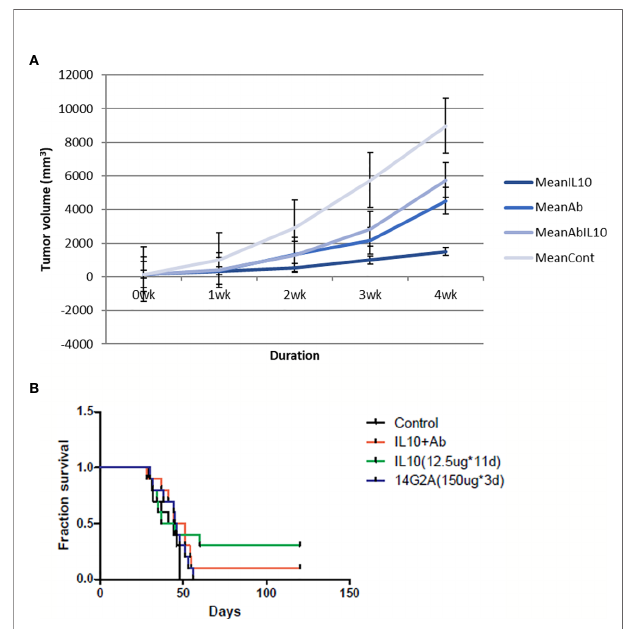
FIGURE 3 | 4T1 tumor volume and mice survival graph after IFN- g injection compared to control mice (n=9 each group). (A) Tumor volume was measured every week after 4T1 cell inoculation with or without IFN- g treatment. Grey line means control group and blue line means the IFN- g group. IFN- g therapy caused statistically signi fi cant tumor volume enlargement (standard error is used in the graph). (B) Mice survival was measured each week after 4T1 cell inoculation with or without IFN- g treatment. Red line means IFN- g treated group and blue line means control group. IFN- g treatment signi fi cantly shortened mice survival. (Likelihood P value=0.01, median survival for control group=40.5 days and for IFN- g treated group=33 days).